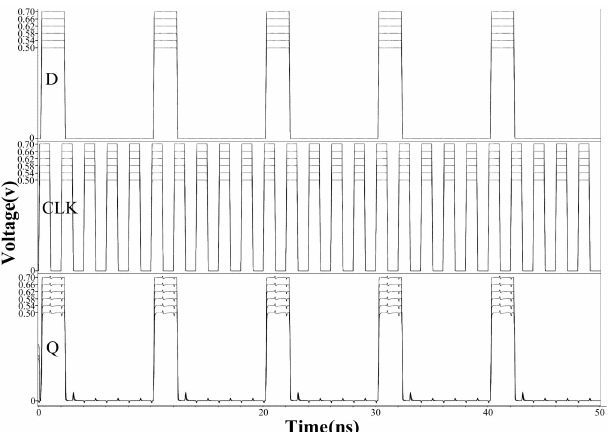
Figure 14. Simulation waveform with supply voltage in sub-threshold/near-threshold regime of the proposed HTNURL